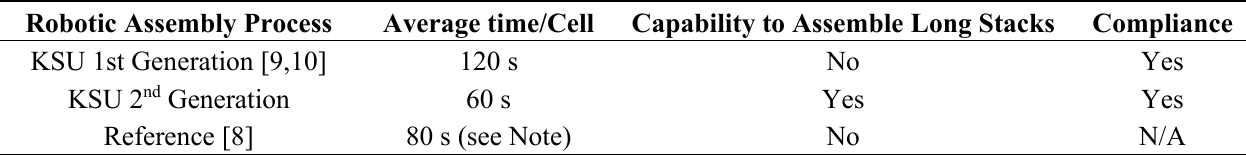
Table 1. Productivity and capability of the robotic assembly process presented here (KSU 2 nd Generation) compared to those in references [8] and [9,10].